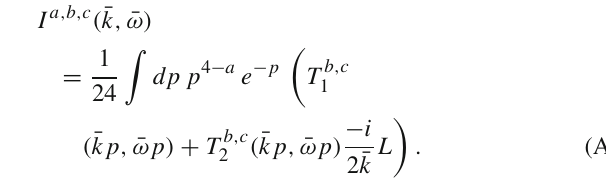
Table 1. To obtain the moments I a , b , c in (A1), it then